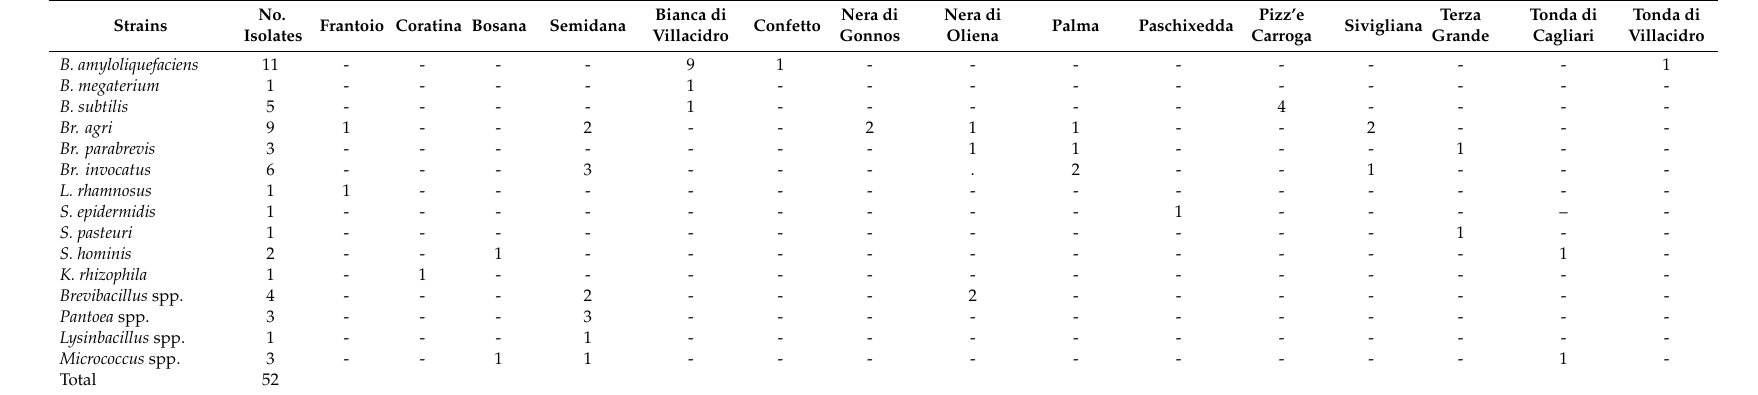
Table 1. Bacteria Isolates divided per species and olive oil